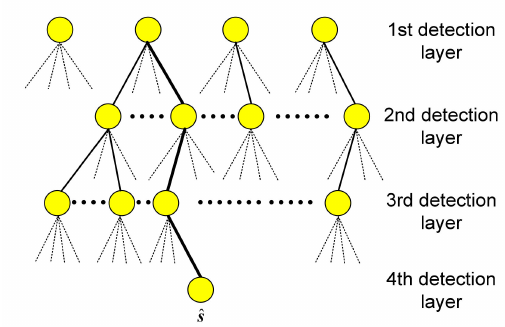
Figure 2. An example of the conventional QRD (QR decomposition) -M ( M = 4) with N = L = 4 and quadrature phase shift keying quadrature phase shift keying (QPSK).